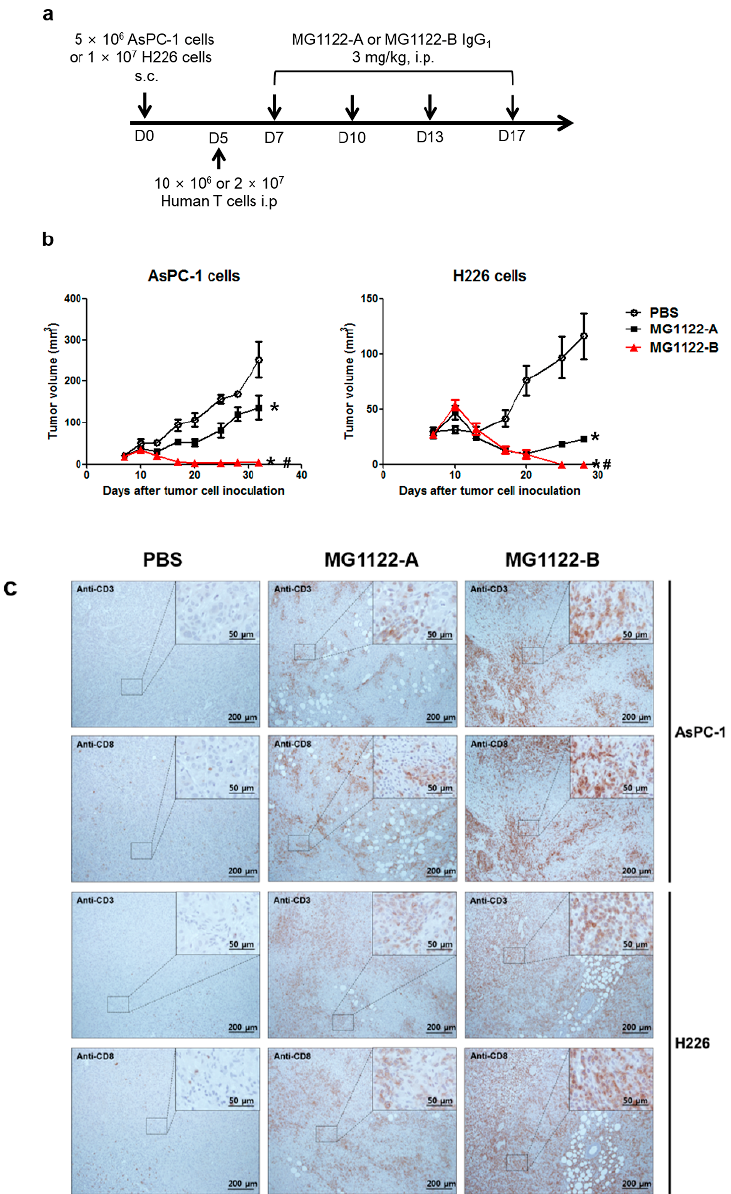
Figure 4. In vivo efficacy of bispecific antibodies in the xenograft model. ( a ) Schematic depiction of the antibody treatment protocol. Human T cells were injected intraperitoneally (effector:target ratio, 2:1) into NOG mice at 5 days after the injection of AsPC-1 or H226 tumor cells. Mice bearing xenograft tumors were treated with MG1122-A or MG1122-B at a dose of 3 mg/kg twice per week, starting at day 7 after tumor cell injection. ( b ) Tumor growth was measured twice per week for the indicated time periods. Data points represent the mean ± standard deviation (SD) of five animals. * p < 0.01 vs. PBS, # p < 0.01 vs. MG1122-A. ( c ) Representative histologic images of tumor sections stained for human CD3 and CD8 (all brown). Scale bars are shown on each panel. Representative images of at least three mice were analyzed in each group.